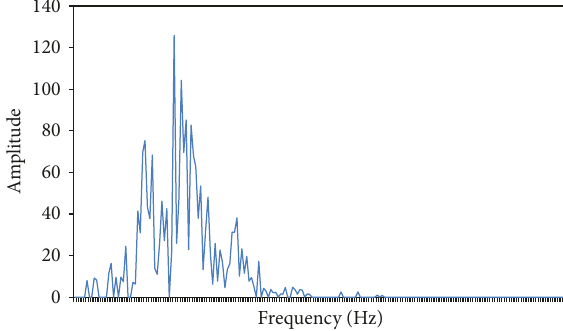
Figure 12: Marginal spectra of IMF-3 signalled with absolute